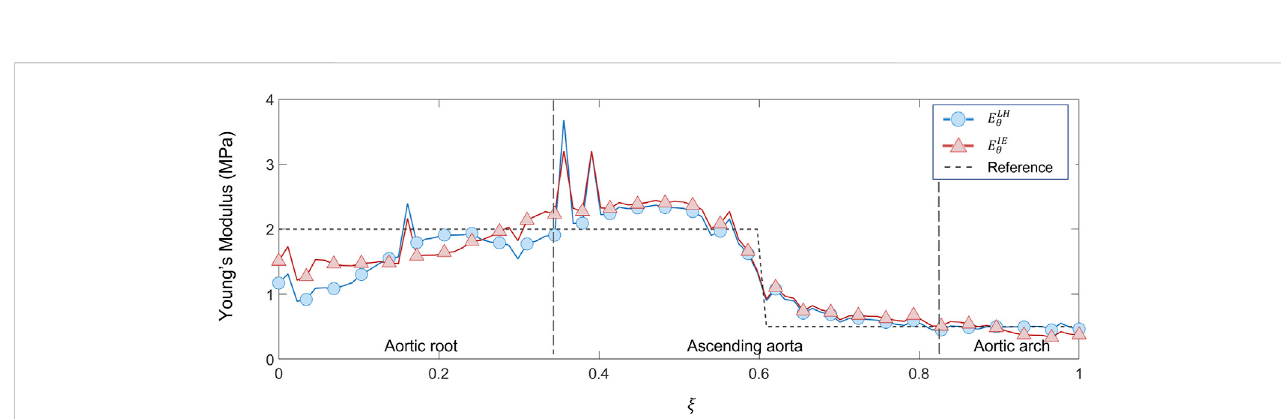
FIGURE 11 Young ’ smodulusvariationalongthecenterlinecoordinate accordingtobothLHandIEmethodsforproximal/distal distributioncasecomparedwiththe reference